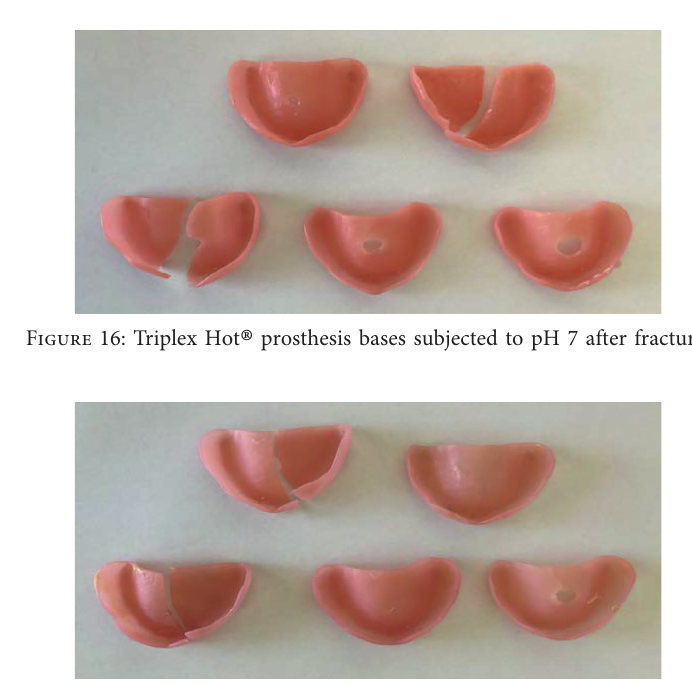
Figure 17: RS Vertex ® prosthesis bases subjected to pH 7 after